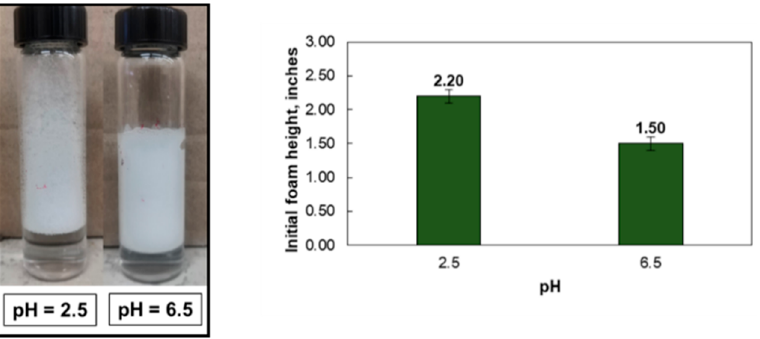
Figure 7. Effect of initial pH on the initial foamability at 10 wt% NaCl, 0.25 wt% surfactant, and 77 °F (25